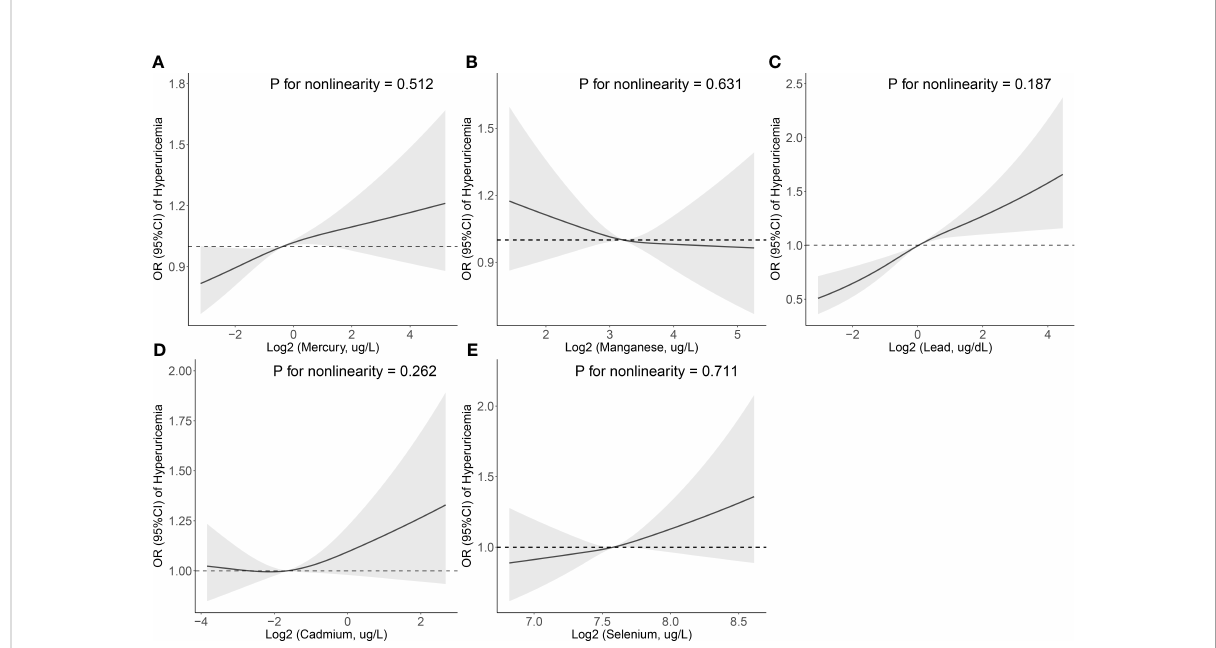
FIGURE 1 Association between the blood metal ( A : Mercury, B : Manganese, C : Lead, D : Cadmium, and E : Selenium) levels and the prevalence of hyperuricemia. The odds ratio of hyperuricemia from a restricted cubic spline logistic regression model with knots at the 10 th , 50 th , and 90 th percentiles. Model was adjusted for age, sex, education level, race, poverty, smoker, alcohol user, energy intake levels, sedentary time, BMI, total cholesterol, high-density lipoprotein cholesterol, eGFR, urinary creatinine, urinary albumin, diuretics, beta-blockers, diabetes, and